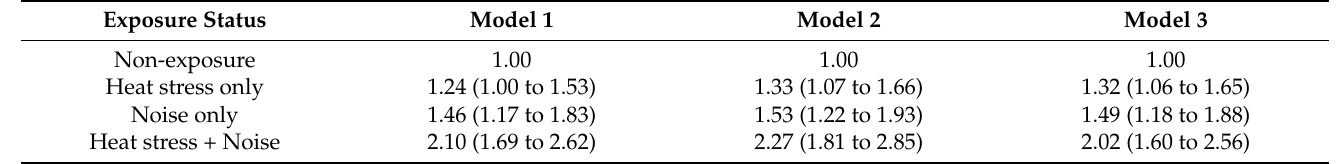
Table 2. Multivariate adjusted ORs between carotid plaque and different occupational exposure status.